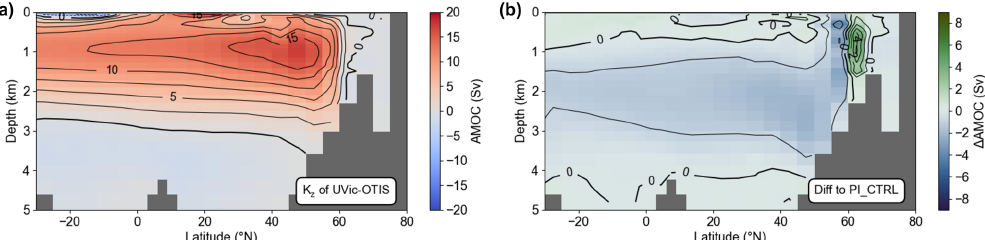
Figure B4. (a) Stream function for model run with the globally uniform diapycnal diffusivity of PI_CTRL replaced with the 3D diapycnal diffusivity field of the UVic-OTIS model with present-day tides (Wilmes et al., 2019). Panel (b) shows panel (a) minus the PI_CTRL simulation. The AMOC strength is ∼ 0 . 7Sv weaker and slightly shallower in the simulation with the 3D diapycnal diffusivity field of the UVic-OTIS model. Contour level steps are 1Sv.